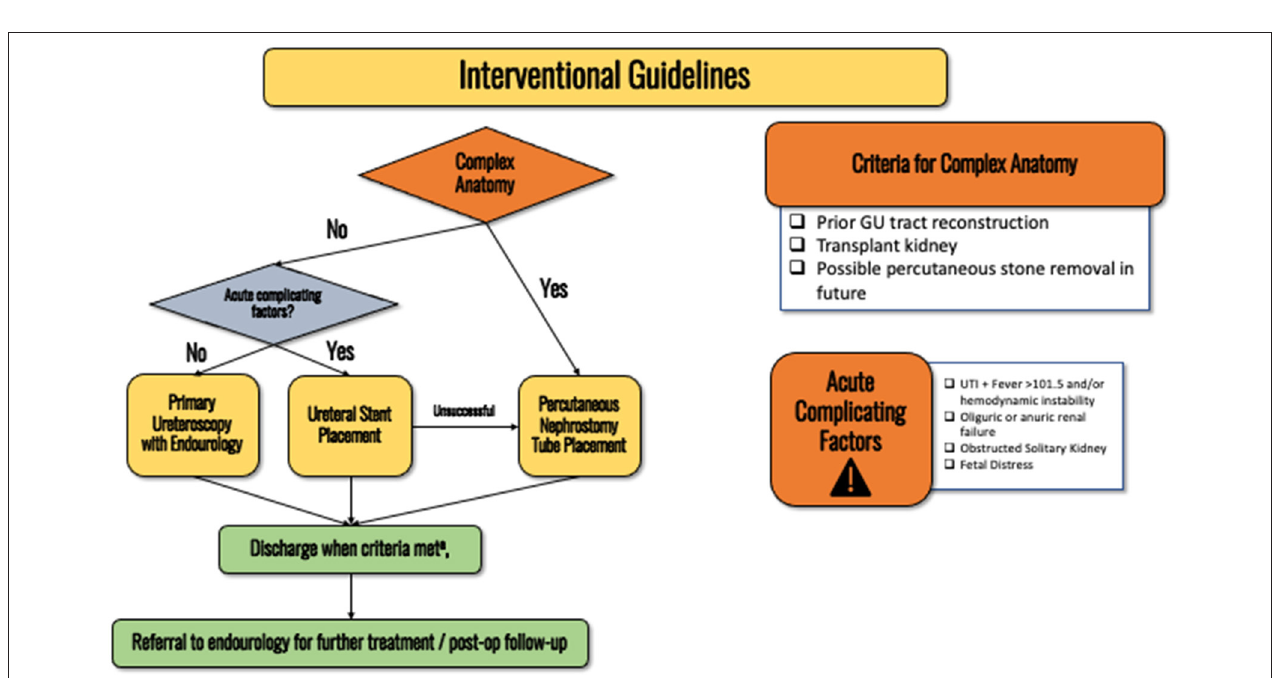
FIGURE 3 | Flowchart detailing the interventional guidelines for obstetric patients with nephrolithiasis. (a) Pain is adequately controlled on oral pain medications, nausea well controlled and able to eat/drink, no AKI and stable creatinine, afebrile, non-concerning fetal monitoring.